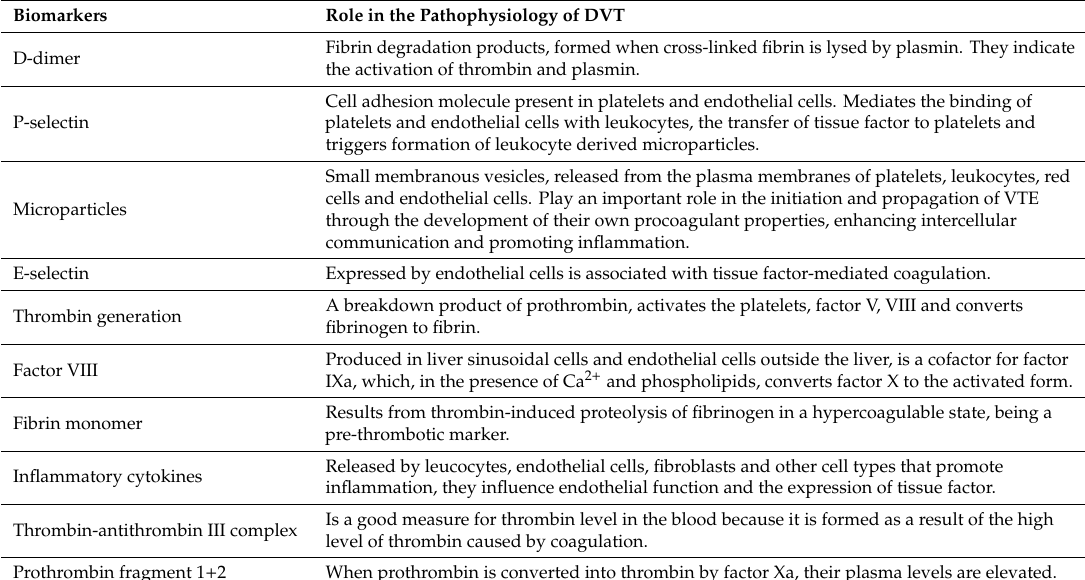
Table 3. The role of di ff erent biomarkers in the pathophysiology of deep vein thrombosis. Biomarkers Role in the Pathophysiology of